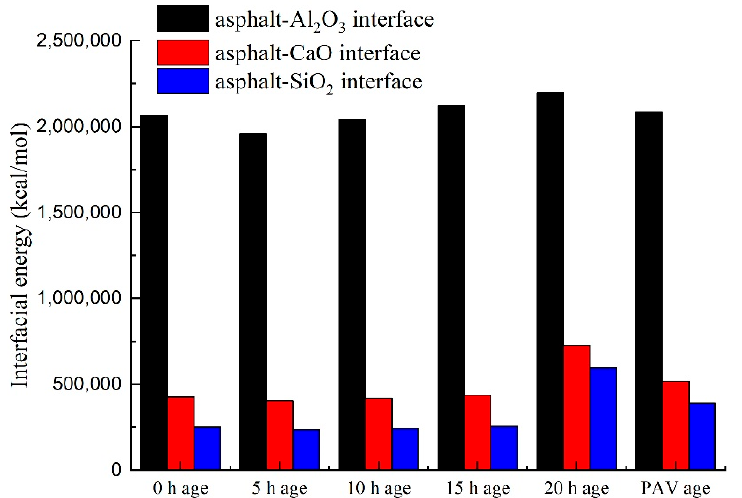
Figure 6. Interfacial energy of the asphalt-binder-aggregate mineral interface.